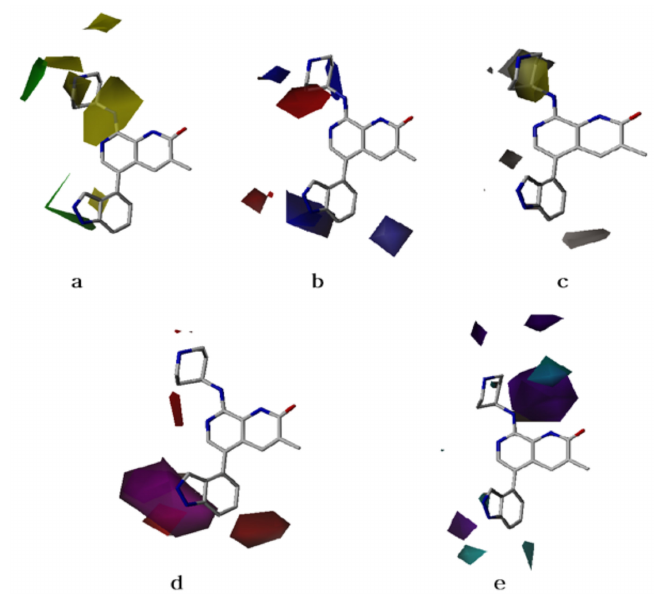
Figure 3. Contour maps of structure-based model on the most active compound ( 42 ) as template